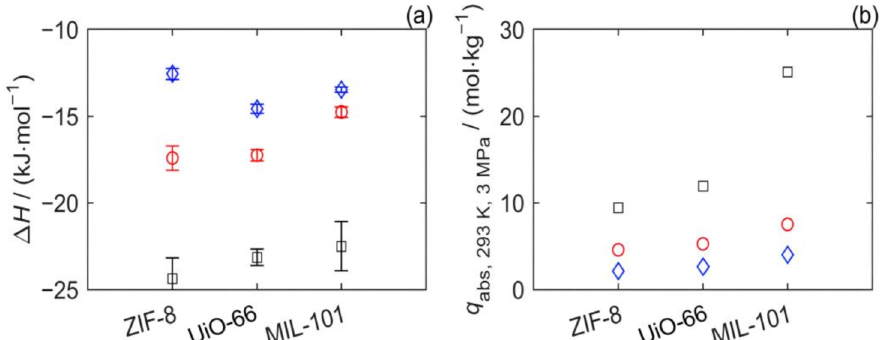
Figure 8. ( a ) Enthalpy of adsorption ΔH and ( b ) absolute adsorption capacity (q abs ) at temperature T = 273.15 K and pressure P = 3 MPa, as calculated with the T th model. □ CO 2 , ○ CH 4 , and ◇ N 2 [68] . Reprinted with permission from ref. [68]. Copyright © 2022, American Chemical Society.